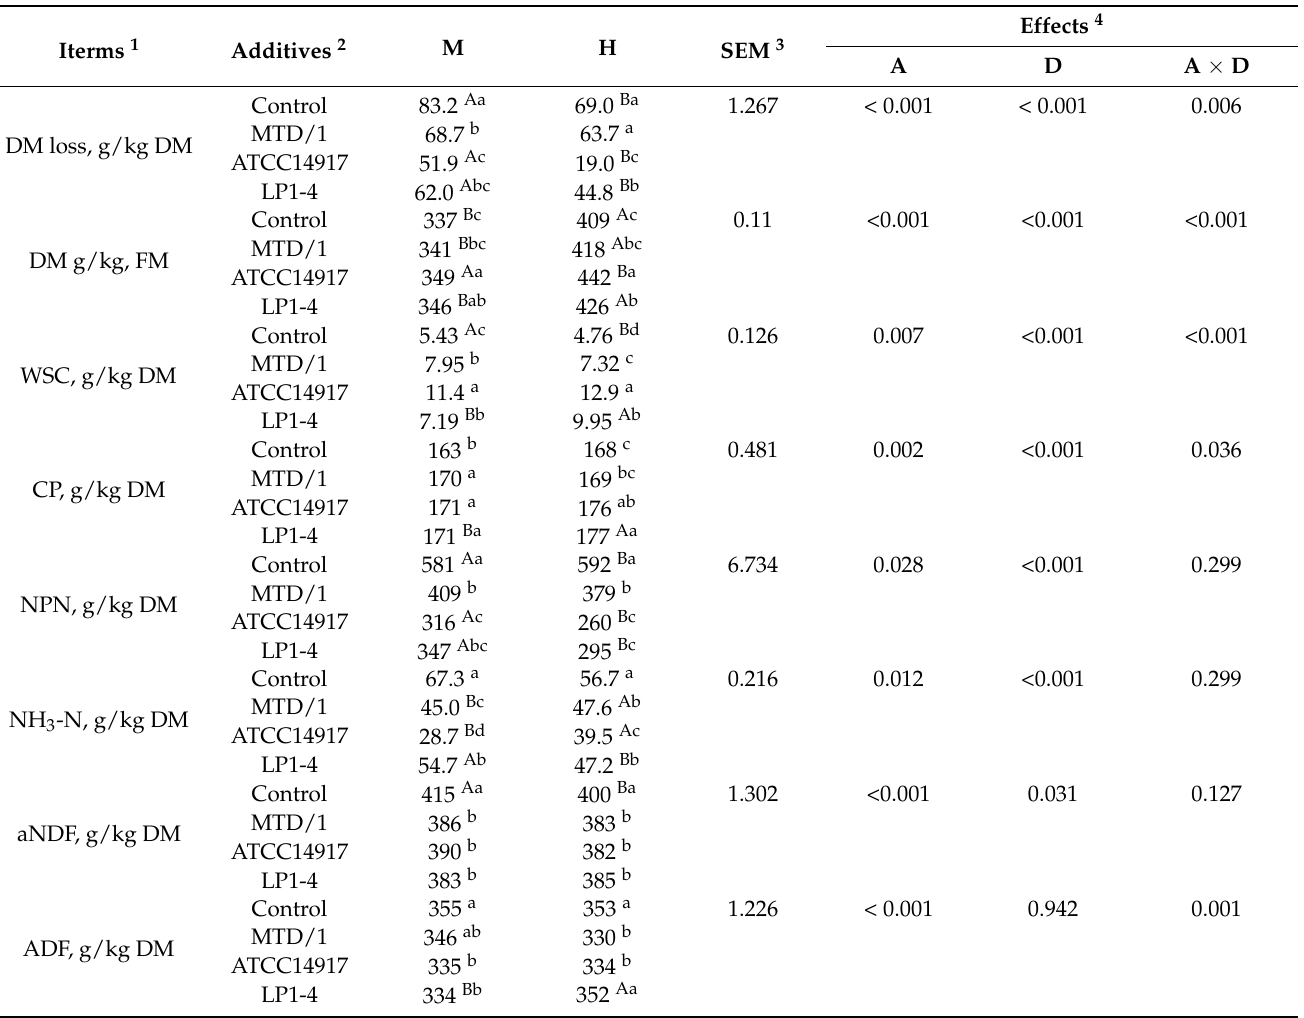
Table 3. Chemical composition of alfalfa silage after 90 d of ensiling ( n =